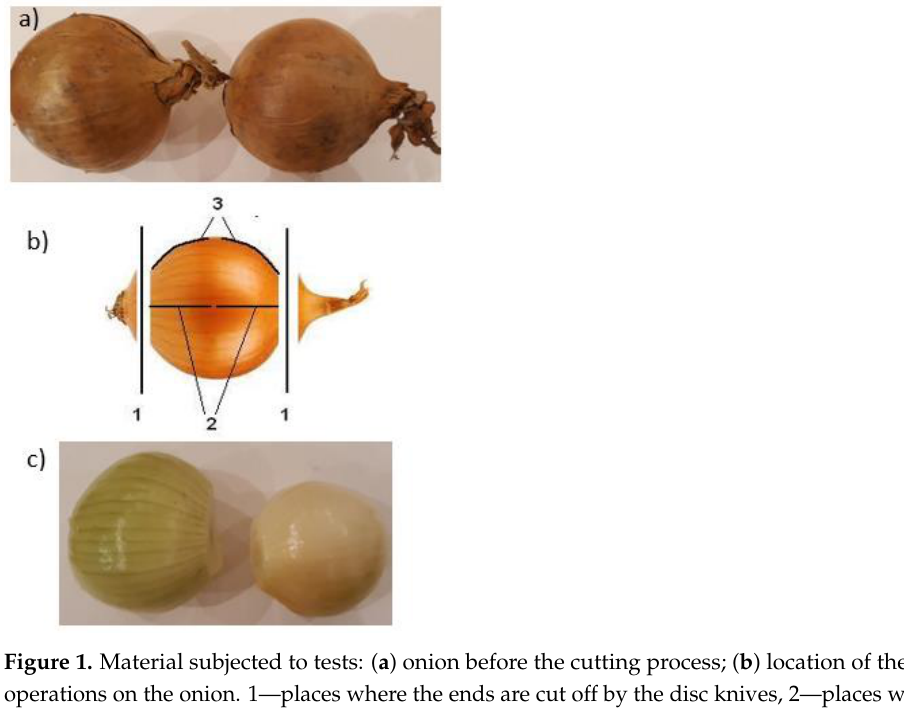
Table 1. Values of independent variables. Independent Variables Values of Independent Variables